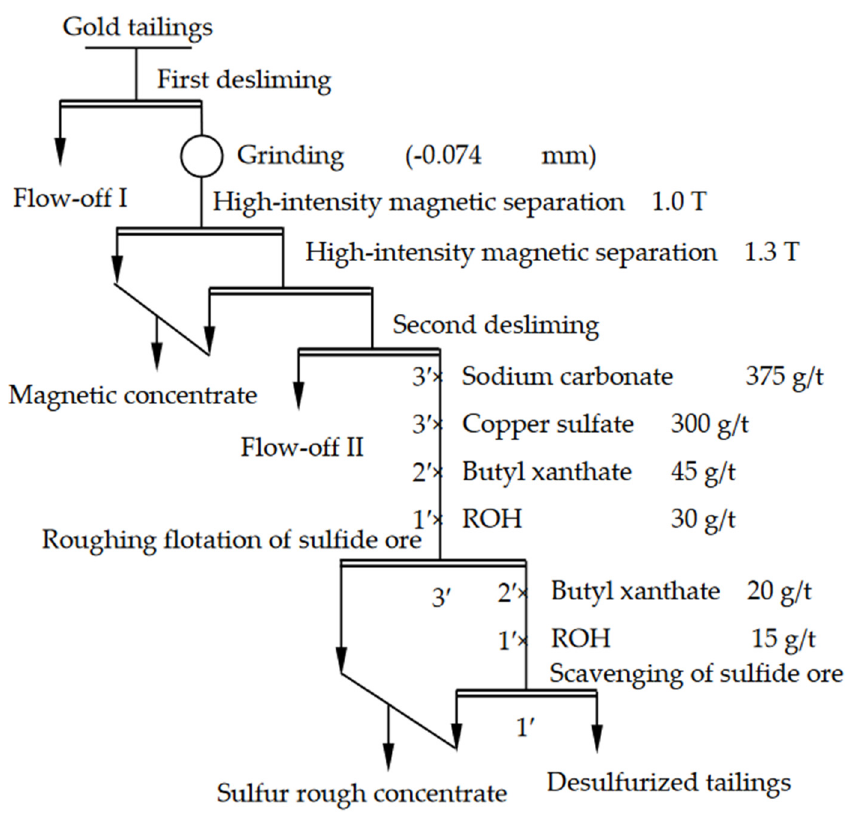
Figure 7. Technological process of gold recovery. Table 6. Results of gold recovery (mass fraction, %).